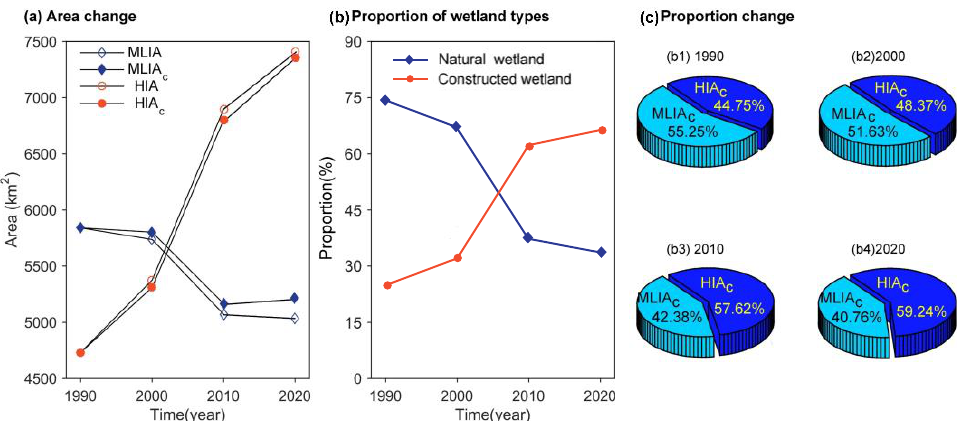
Figure 5. The area and proportion change of different inundation frequency and wetland landscapes in the YRD from 1990 to 2020. ( a ) The area of MLIA, MLIA c , HIA, and HIA c . ( b ) The proportion change of natural and constructed wetlands. ( c ) The proportion of MLIA c and HIA c .